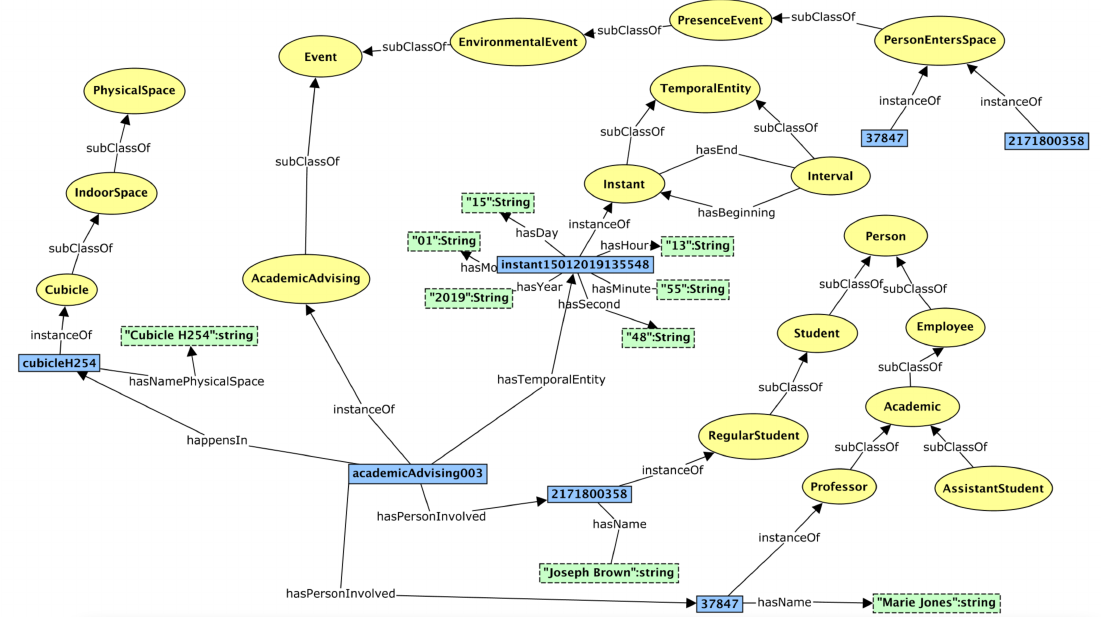
Figure 9. Ontological model instantiated with an academic advising event (scenario